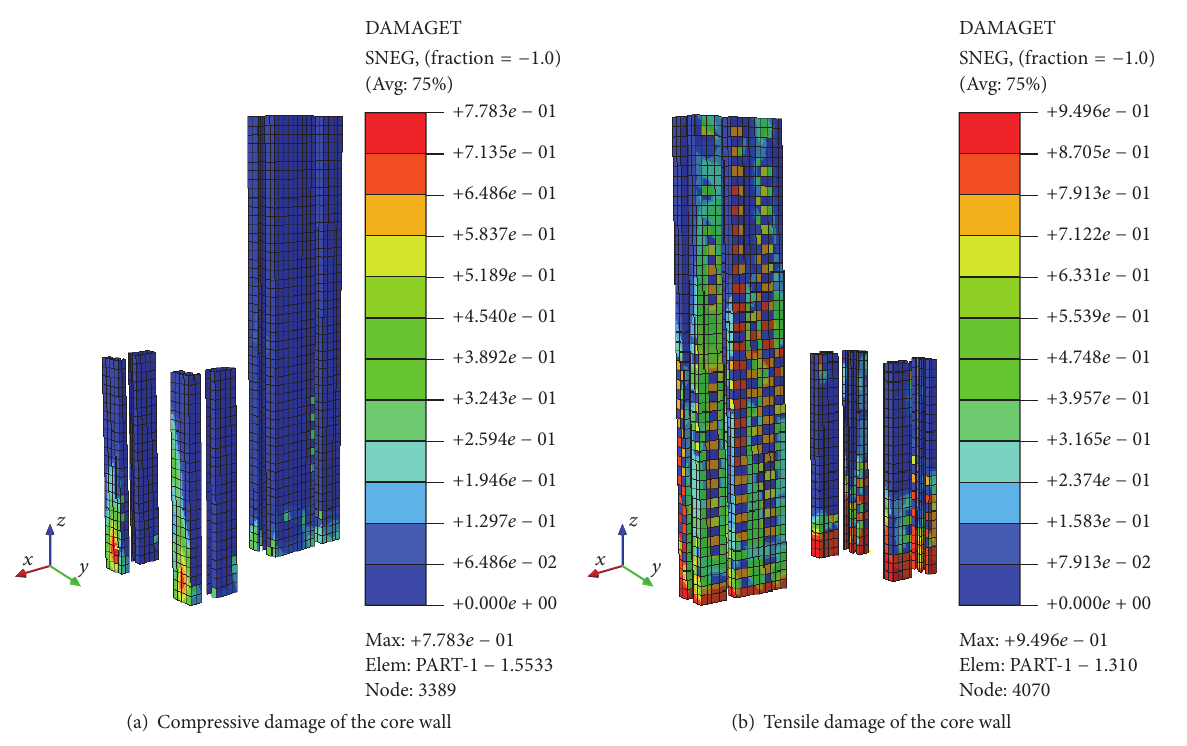
Figure 25: Damage patterns of concrete of the core wall under rare intensity 7 earthquakes